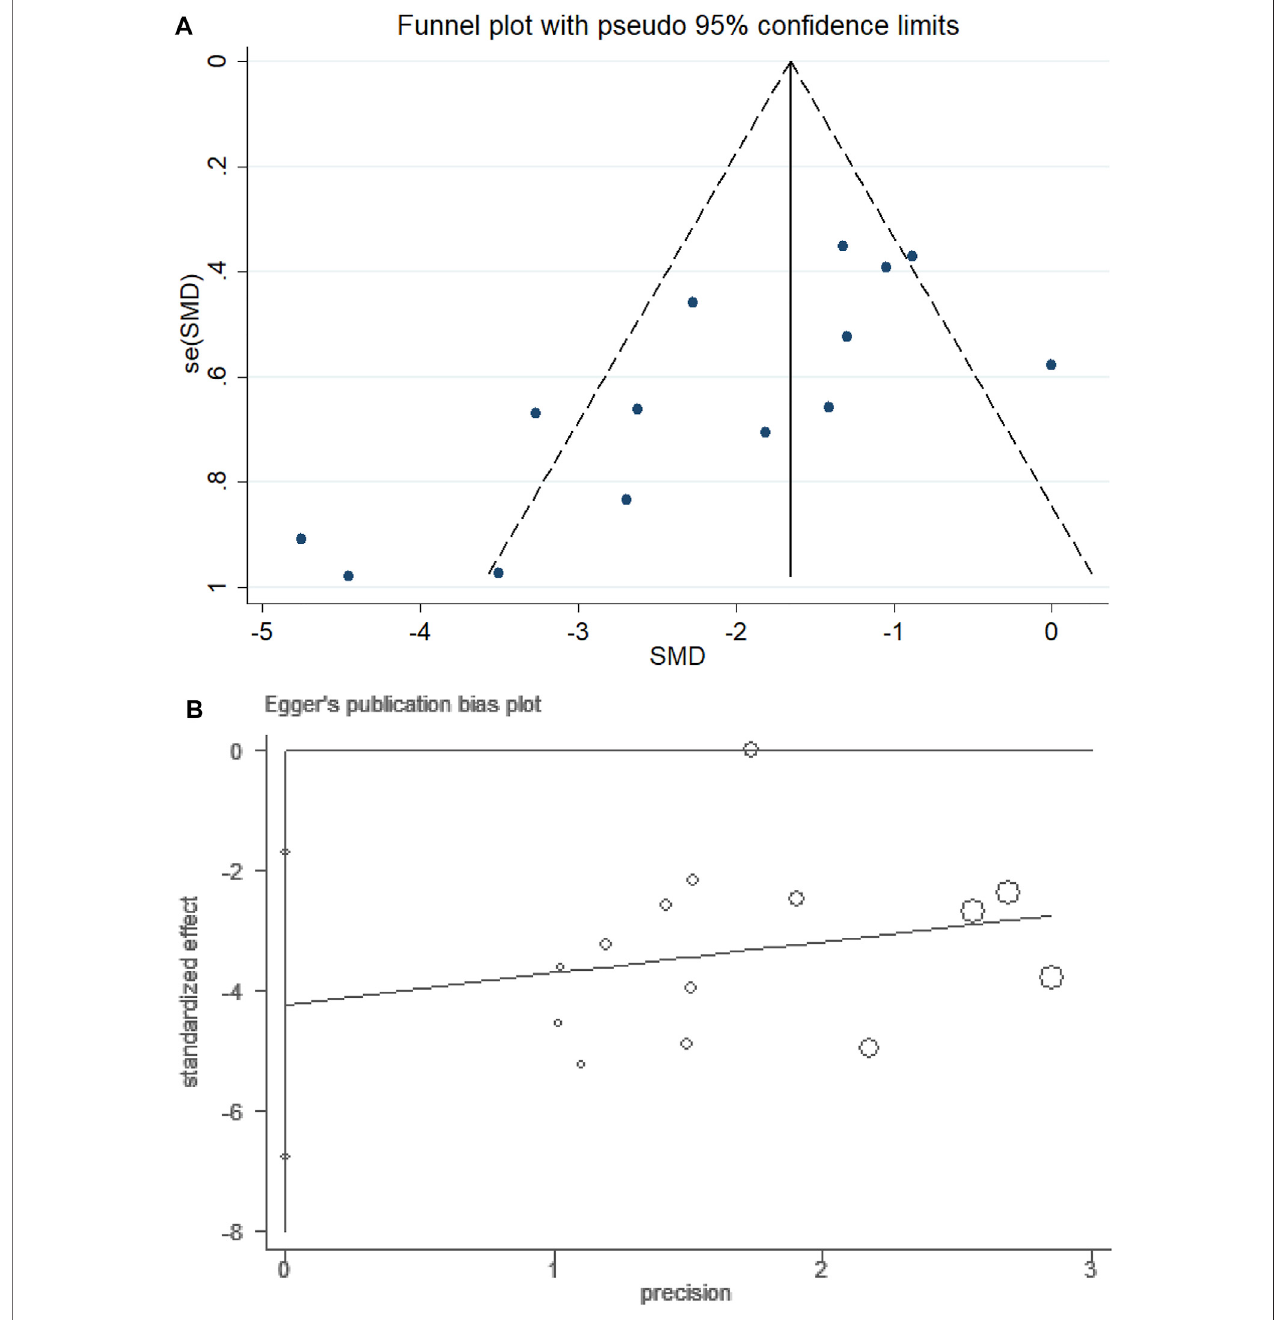
FIGURE 8 | Funnel plot of PF for NSS. (A) Assessment of publication bias in a funnel plot. (B) Bias assessment plot by Egger ’ s test.